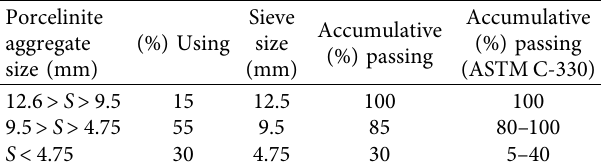
Table 6: Grading of coarse porcelinite